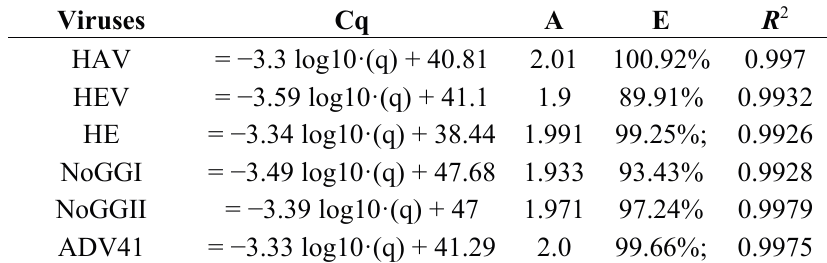
Table 2. Absolute quantification was analyzed using LightCycler Nano Software